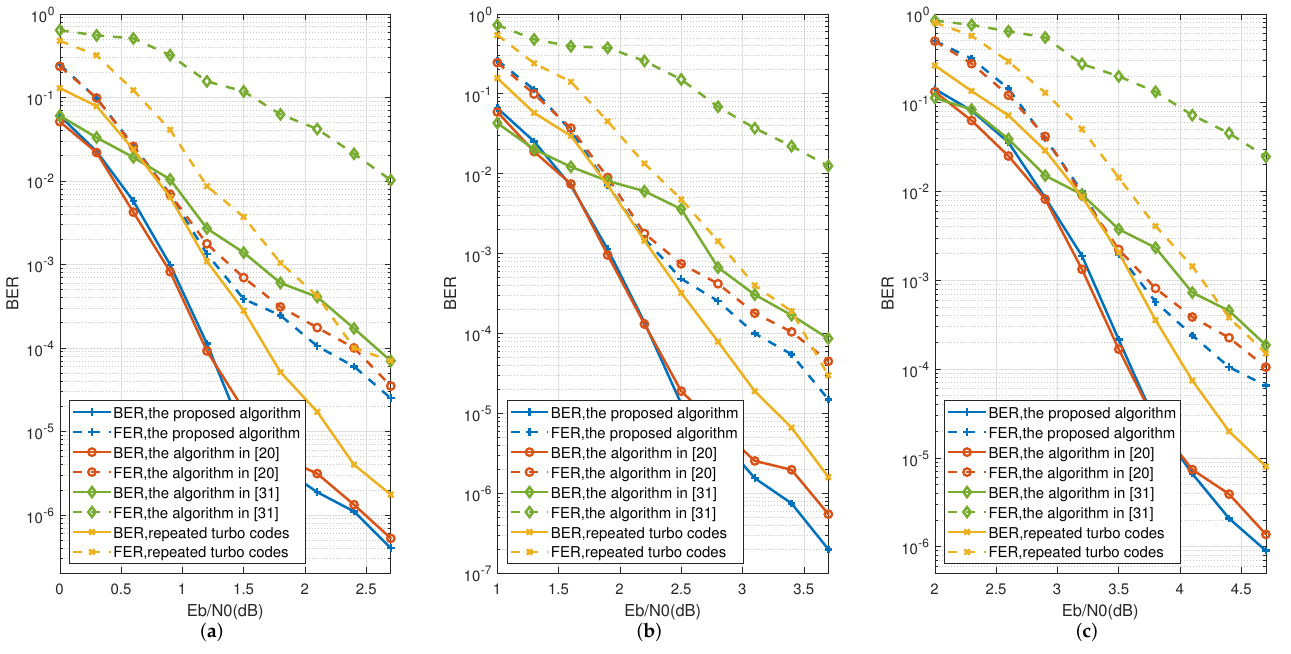
Figure 10. Error performance of turbo-Hadamard codes with r = 5 with no jamming ( a ), 20% ( b ), 40% ( c ) frequency bins to be